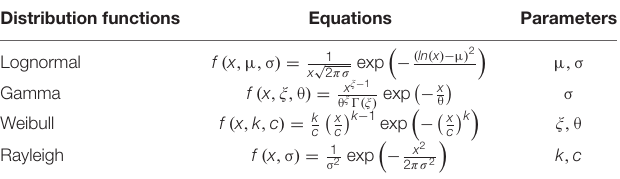
TABLE 1 | Four distribution functions. Distribution functions Equations